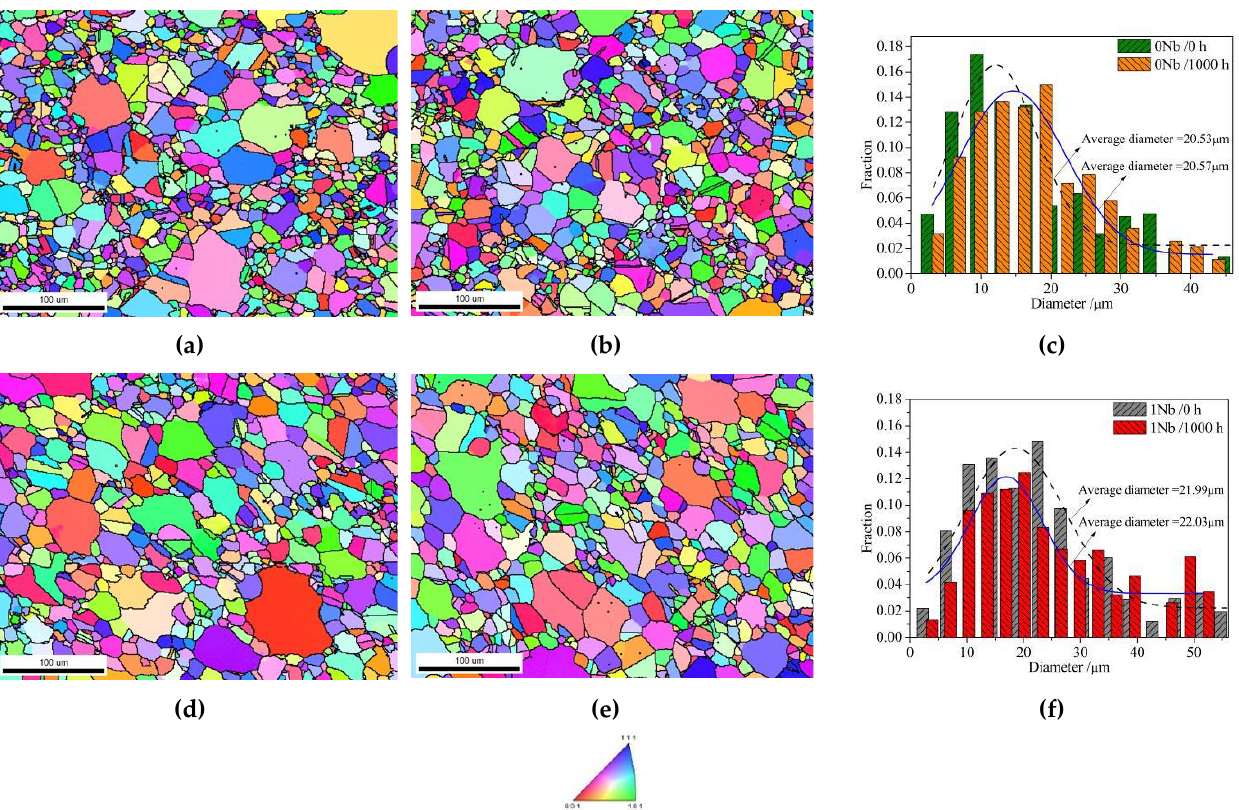
Figure 7. Inverse polar figure (IPF) of ( a ) 0Nb/0 h; ( b ) 0Nb/1000 h; ( d ) 1Nb/0 h; ( e ) 1Nb/1000 h; grain size distribution of ( c ) 0Nb; ( f ) 1Nb.